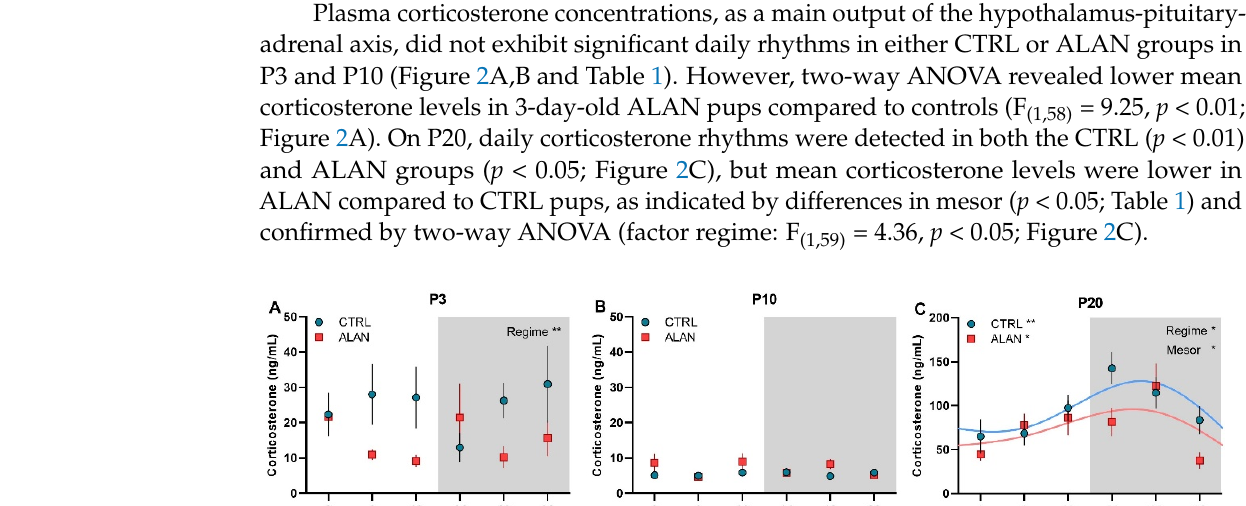
Figure 2. Effects of gestational dim ALAN (~2 lx) on the early development of daily corticosterone rhythms. The daily pattern of plasma corticosterone levels on postnatal day P3 ( A ), P10 ( B ), and P20 ( C ) in rat pups that were delivered by mothers exposed to either the control light–dark cycle (CTRL) or ALAN during pregnancy. Symbols represent the mean ± SEM, n = 5–6 rats per time point and group. The significant 24-h rhythms are fitted with a cosine curve for CTRL (blue solid line) and ALAN (red solid line) groups at ** p < 0.01 and * p < 0.05. Non-rhythmic data are not fitted with the cosine curve. A significant difference in mesor of the rhythms is indicated at * p < 0.05. Significant main effects of Regime from two-way ANOVA are indicated at ** p < 0.01, * p < 0.05. Zeitgeber time 0 = light on. Grey area represents the dark phase. Note different scales in